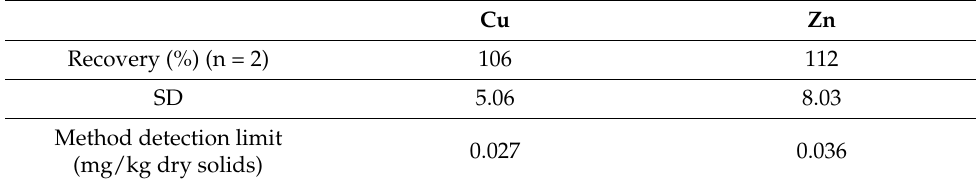
Table 1. Recoveries for the CRM and method detection limits for AA analysis. Cu Zn Recovery (%) (n = 2) 106 112 SD 5.06 8.03 (mg/kg dry